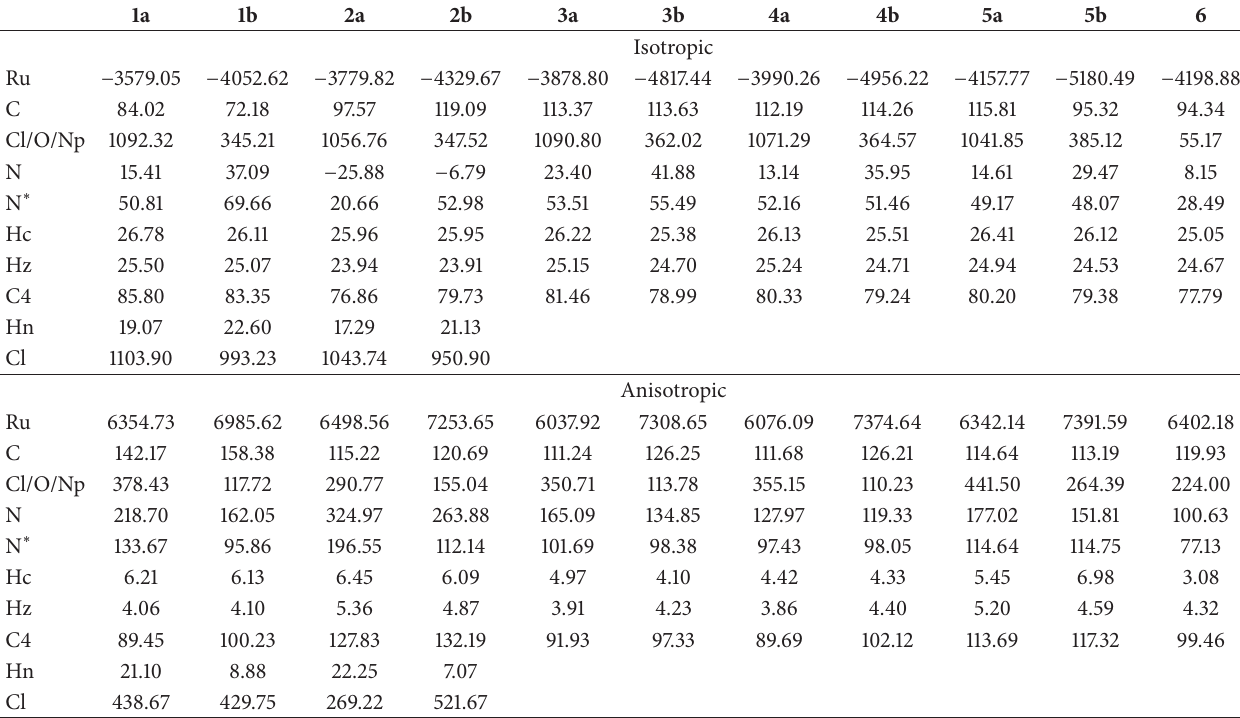
Table 4: The isotropic and anisotropic shielding tensor of selected atoms of interest in the complexes.